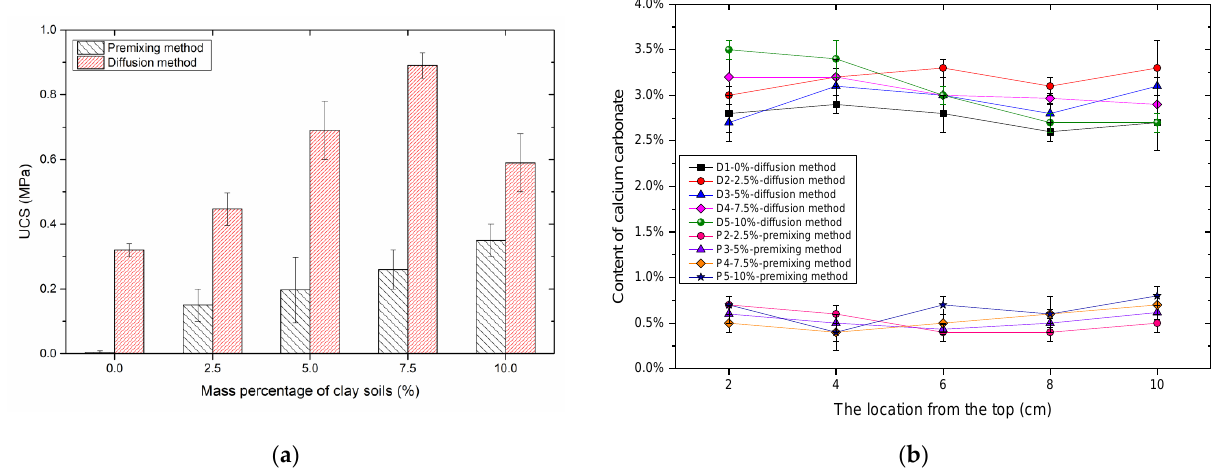
Figure 4. Comparison of treated samples with two different methods: ( a ) unconfined compressive strengths; ( b ) contents of calcium